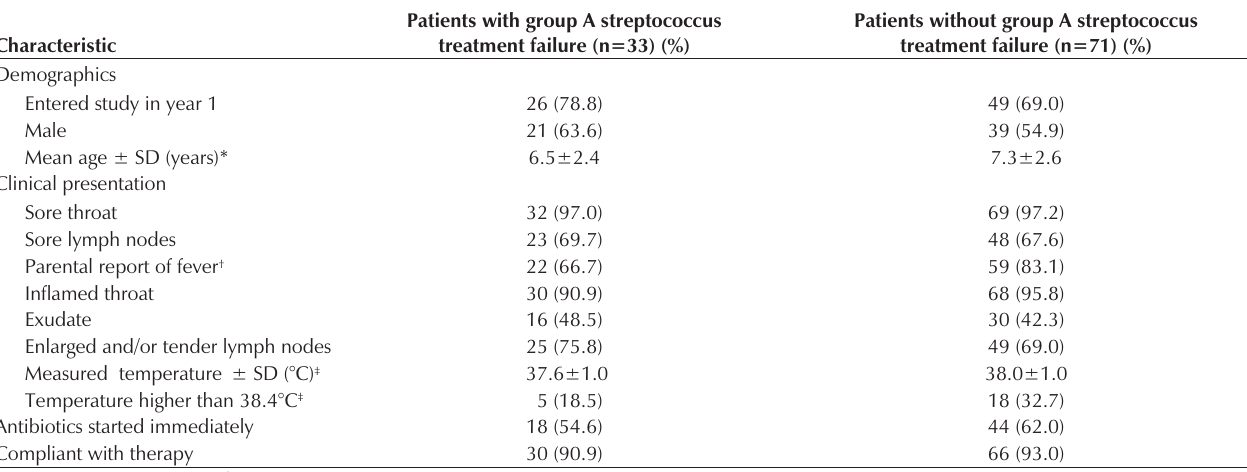
38.4°C on presentation, eight (34.8%) were afebrile and nine (39.1%) had no temperature recorded; ‡ Data recorded for 27 children with treatment failure